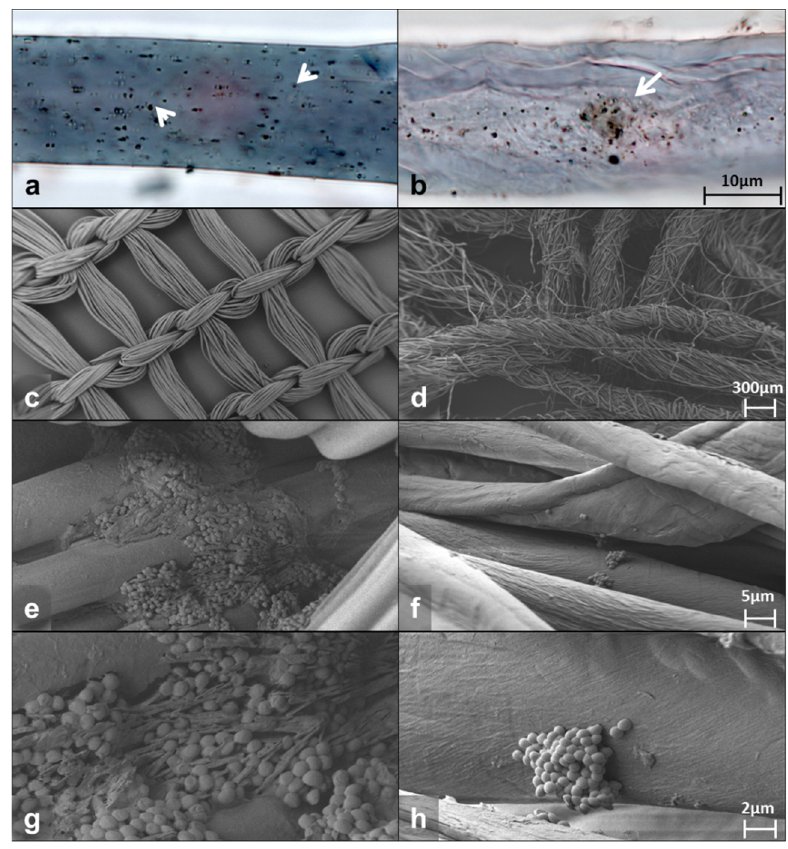
Figure 1. Representative photomicrographs of the DACC-coated dressing (left panels) and gauze (right panels) cultured with S. aureus in supplemented DMEM. Bright-field images ( a , b ); SEM images ( c – h ).